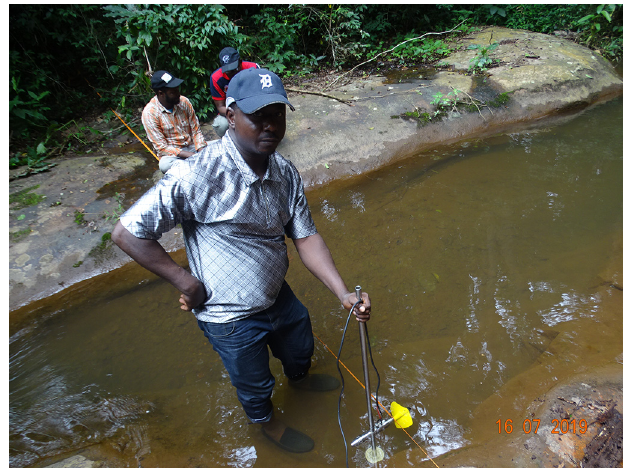
Fig. 13. Field training on head measuring at Firadou (cid:1) Guinea (Photo J. Kenfack).